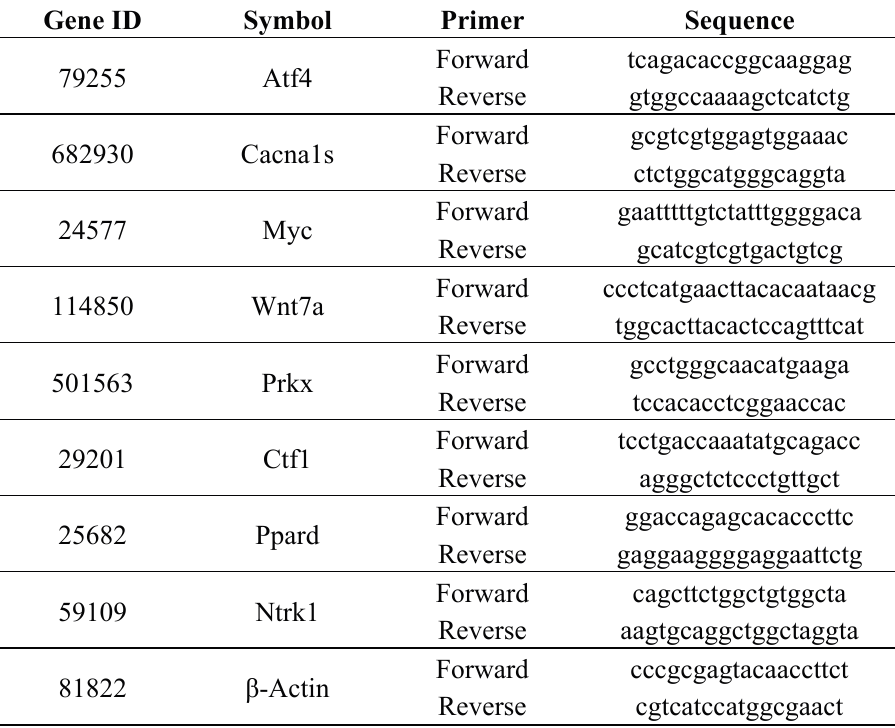
Table 7. Oligonucleotides primers used in this study for quantitative real-time-PCR analysis. The primer sequences were designed by using the ProbeFinder version